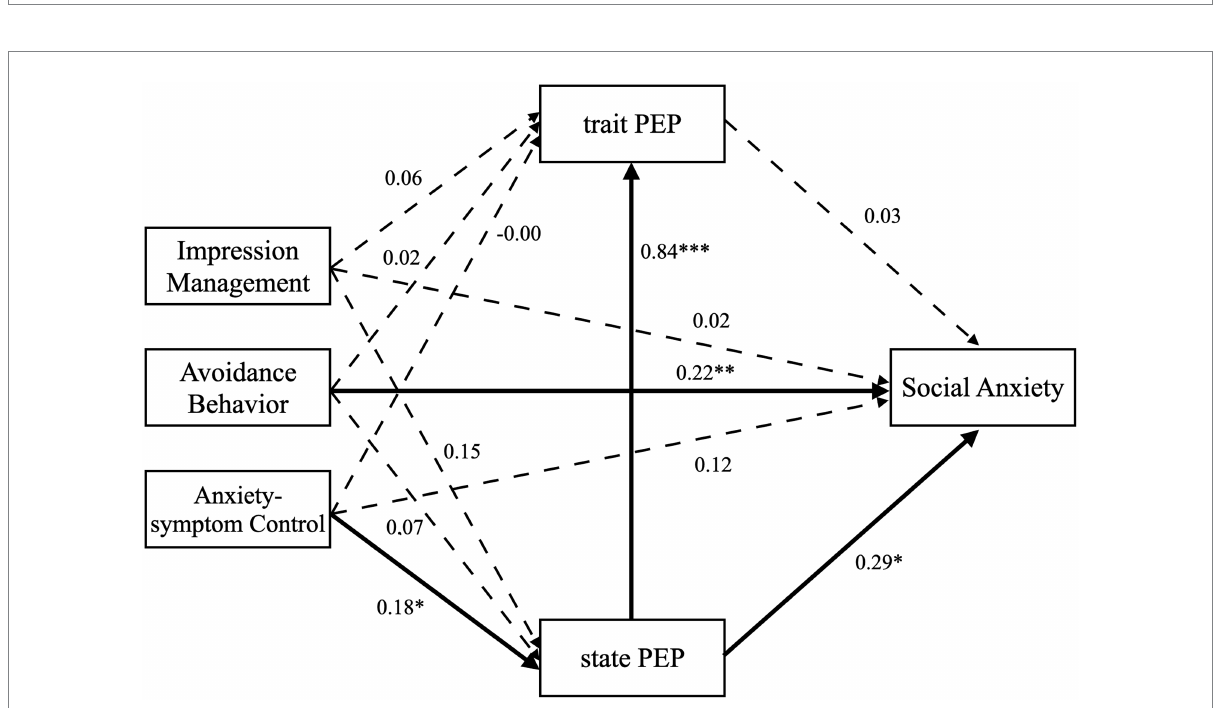
FIGURE 2 The serial mediation effects between the three subtypes of behavior and social anxiety in low SA group. The dotted lines represent non-significant paths, and the solid lines represent significant paths, * p < 0.05, ** p < 0.01 and *** p <